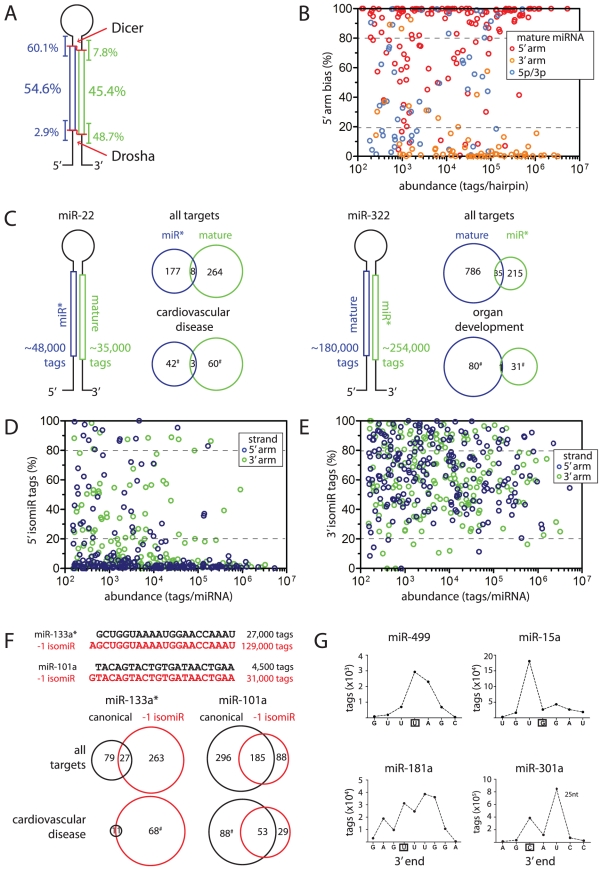
Diversity of HL-1 cardiomyocyte miRNA processing.(A) Schematic of hairpin miRNA precursor showing proportion of tags derived from either 5′ (blue) or 3′ (green) arm (in % of total hairpin-mapped tags; shown at center of boxed regions). For each arm, the proportion of tags representing 5′ start or 3′ end positions that vary from miRBase annotation is also shown (in % of tags per arm; shown at ends of boxed regions). Red lines indicate typical Dicer and Drosha processing sites. (B) 5′ strand bias of each miRNA is plotted against the sum of tags per hairpin. Color scheme represents miRBase version 16 annotation as mature species on 5′ or 3′ arms (red and orange circles, respectively), or as a 5p/-3p pair (blue circles). (C) Examples of miRNAs with unexpected strand bias. Schematics of hairpin indicate abundance of tag mapping to opposing arms (on left), while Venn diagrams indicate number and overlap of predicted mRNA targets (Targetscan) for each of these miRNA (on right; top: all predicted targets, bottom: only targets with specific gene function annotation (Ingenuity) as listed; #: significant enrichment of gene function term, p<0.01). (D) The proportion of tags representing 5′ isomiRs for each miRNA is plotted against tag abundance. Color scheme represents position of miRNA on 5′ (blue) or 3′ (green) arm. (E) As in (D) but showing prevalence of 3′ isomiRs. (F) Examples of miRNAs with high 5′ isomiR proportion. Tag sequences representing canonical miRNA (black) and major 5′ isomiR (red) are depicted on top, while analyses of mRNA targets (as in D) are shown below. (G) Examples of distinct miRNA 3′ end variability. Distribution of tag 3′ ends for miR-499 is from the heart biopsy, while HL-1 cell data is shown for miR-181a, miR-15a and miR-301a (miRBase-annotated 3′ end positions are boxed). Panels (B, D and E) depict only generic miRNAs (tags with 5′ start position +/− 3 nt of miRbase v16 annotation or novel miR* directly juxtaposed to a known miRNA) with an expression level of ≥150 tags; the dashed lines show tag proportion thresholds of 80% and 20% used throughout this study to categorize miRNAs.